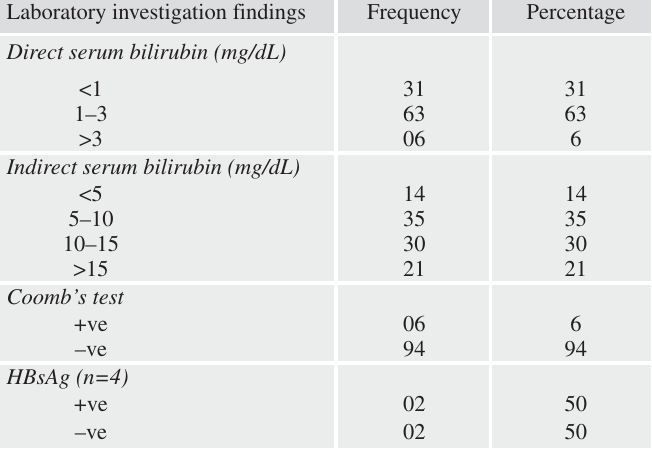
Table III: Laboratory investigation findings of the newborns (n=100) Laboratory investigation findings